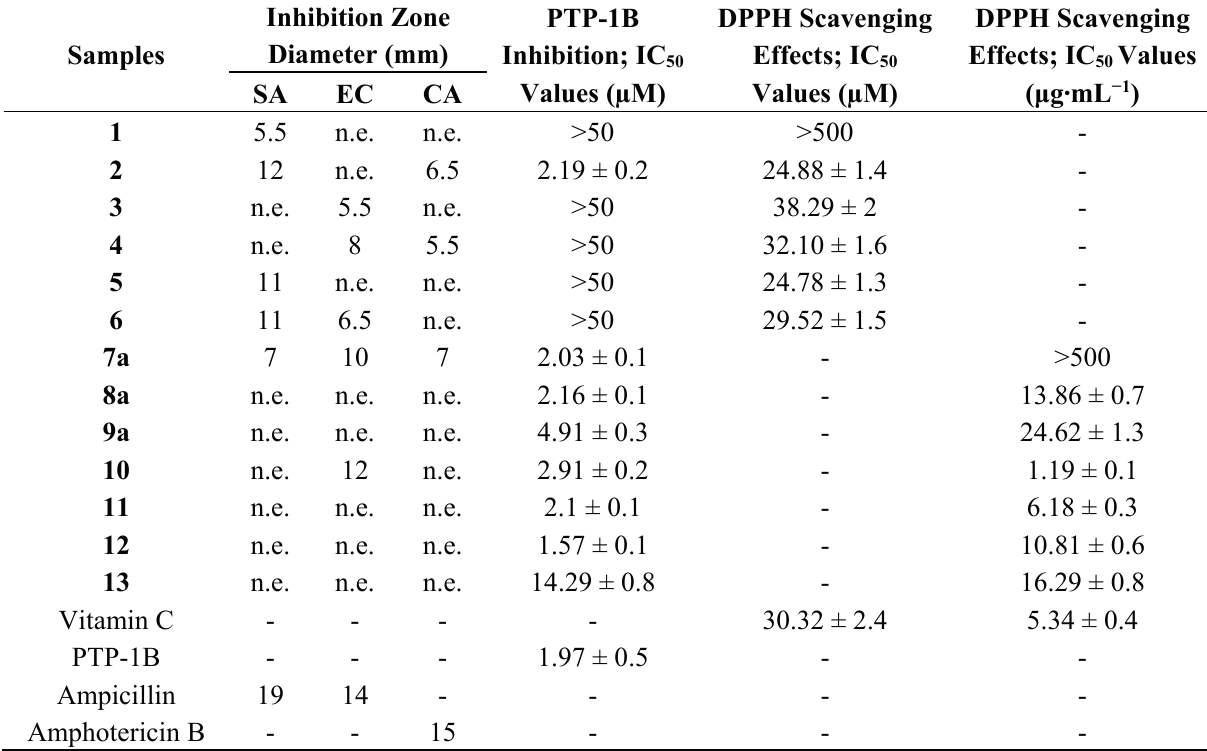
Table 1. In vitro screening of IC 50 values, inhibition zone (mm) PTP-1B inhibition and DPPH activities of the tested compounds 1 – 6 and 7a , 8a , 9a , 10 – 13 .